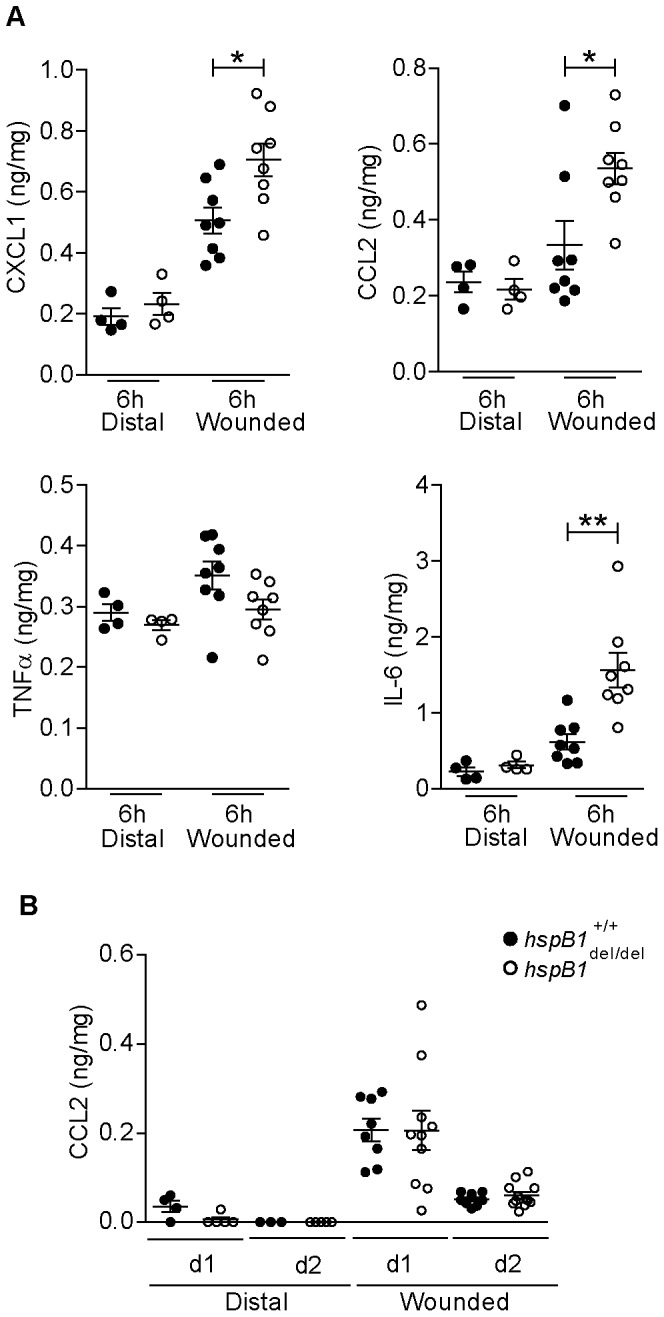
HspB1 deficiency promotes cytokine expression at 6-wounding.A, Plots of cytokine protein expression in homogenised 6(wounded) and distal unwounded tissue (distal) measured by ELISA and expressed as amount of cytokine protein/total protein in wound tissue sample analysed (**P<0.01; *P<0.05). B, Plot of CCL2 protein expression as in (A) but for d1 and d2 post-wounding.